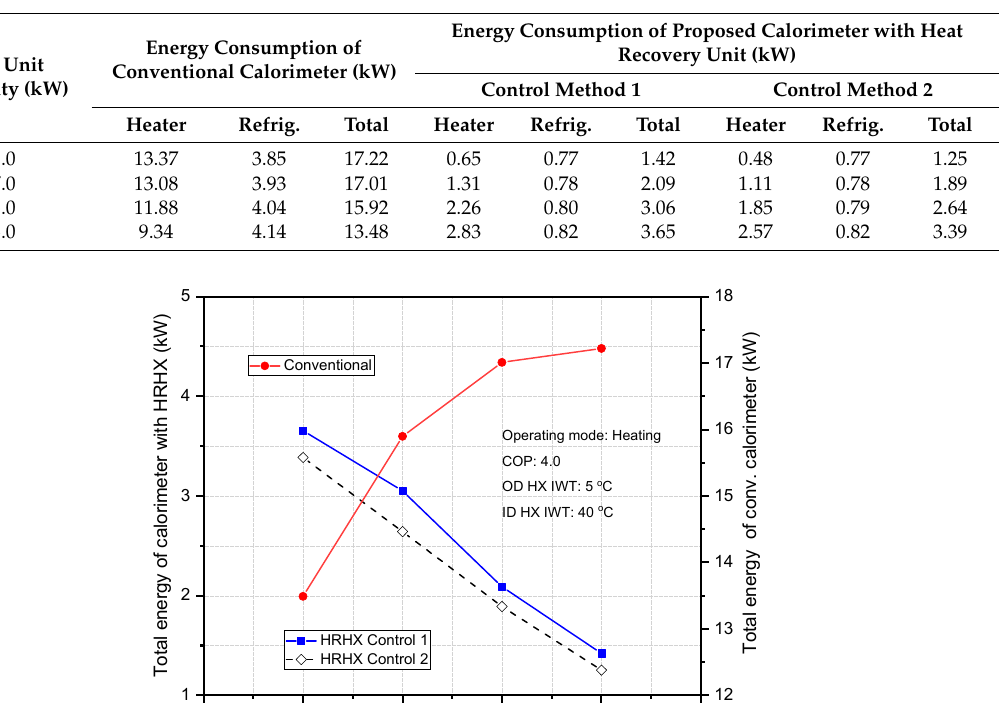
Table 3. Energy consumption data for a conventional calorimeter and the proposed calorimeter with a heat recovery unit in heating mode.